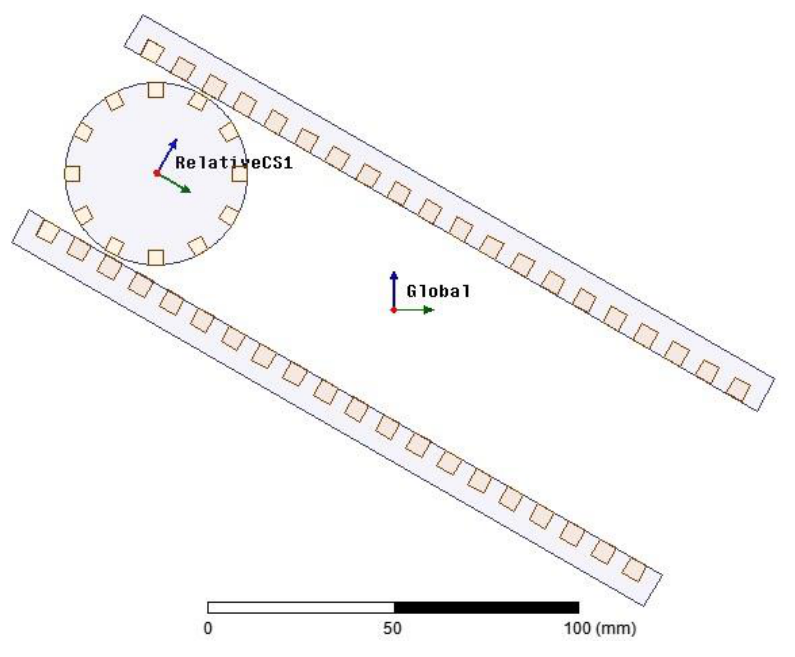
Figure 11. Defined coordinate systems.